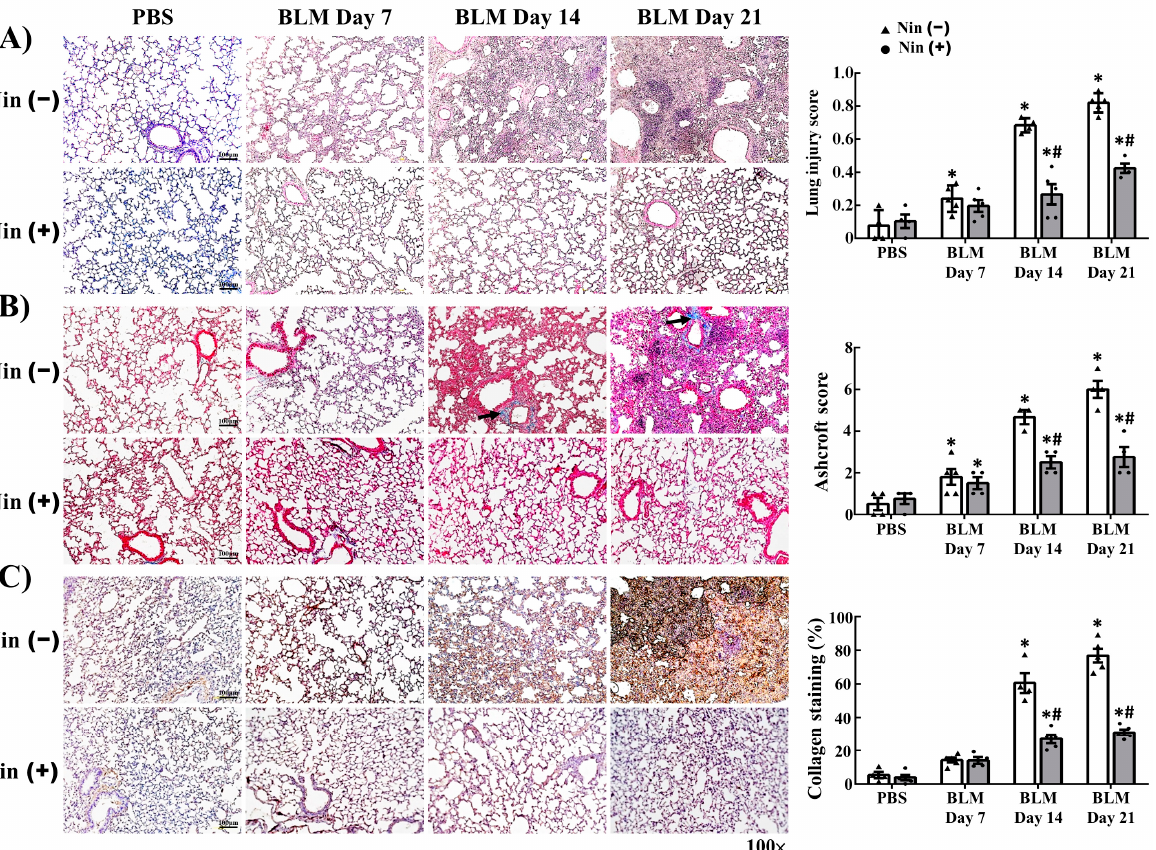
Figure 1 . Nintedanib ameliorates BLM-induced pulmonary injury and fibrosis. ( A ) Representative hematoxylin and eosin staining images and lung injury scores of BLM-treated murine lung sections with or without nintedanib treatment. ( B ) Representative Masson’s trichrome staining images and Aschroft scores of BLM-treated murine lung sections with or without nintedanib treatment. Black arrows indicate collagen. ( C ) Representative IHC staining images and semi-quantification of colla- gen-1 in BLM-treated murine lung sections with or without nintedanib treatment. BLM, bleomycin; IHC, immunohistochemistry; Nin, nintedanib; PBS, phosphate-buffered saline. Scale bars, 100 µm. n = 3–5 in each group. Data are presented as mean ± standard deviation. * p < 0.05 vs. PBS, and # p < 0.05 vs. BLM (two-tailed Student’s t-test).